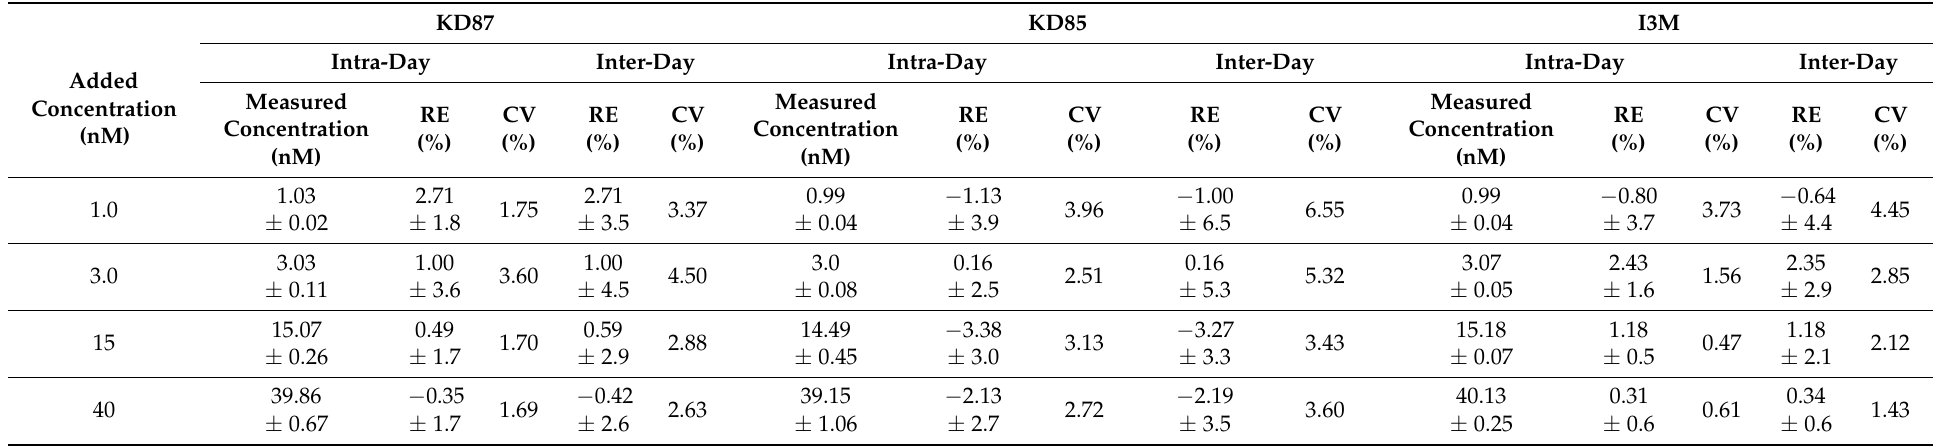
Table 4. Inter- and intra-day accuracy, expressed as relative error (RE) ± standard deviation (SD) and precision, determined as coefficient of variation (CV), of different samples each from three days of KD87, KD85, and I3M at LLOQ level (1 nM), low (3 nM), medium (15 nM), and high (40 nM) concentrations after extraction from DMEM. The measured concentrations are given as mean values ± SD, n = 5–6 for intra-day, n = 20–24 for